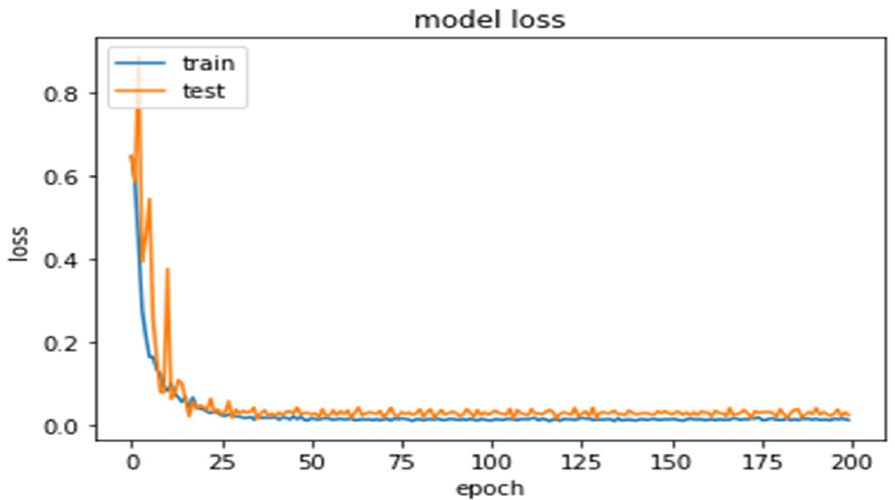
Figure 8. Model’s training and test accuracy Adam and LeakyReLU.